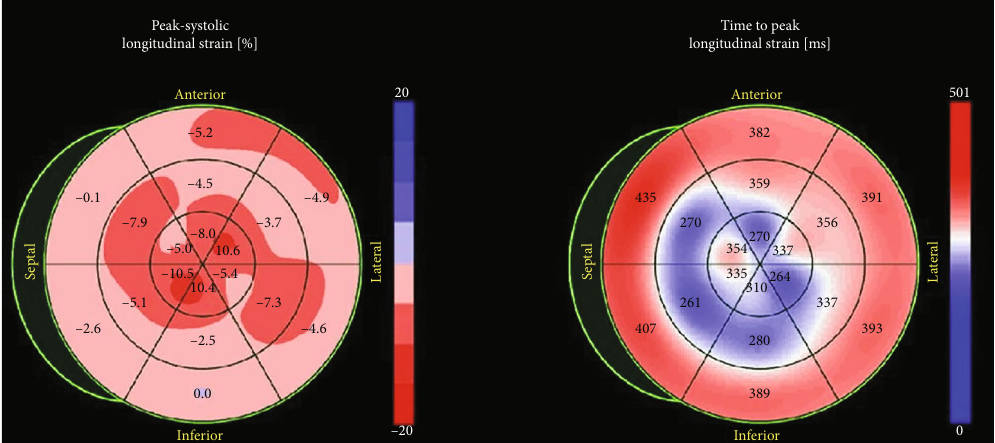
Figure 2: Echocardiographic polar map highlighted a decrease in global longitudinal strain.